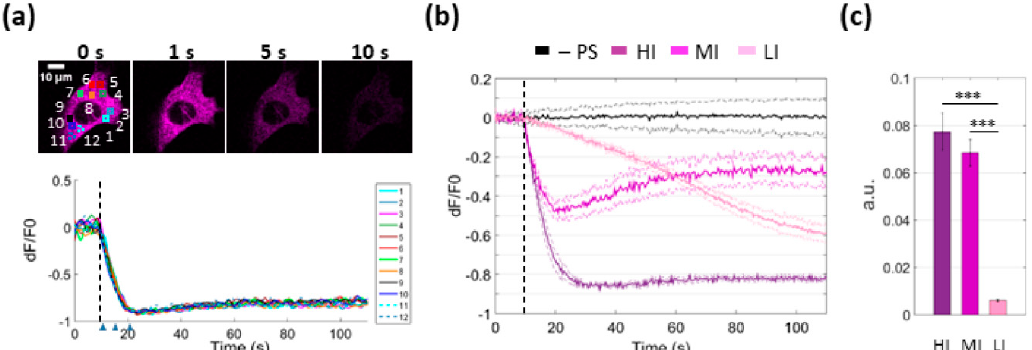
Figure 3. PS activation triggers Ca 2+ release from the endoplasmic reticulum (ER). [Ca 2+ ] ER